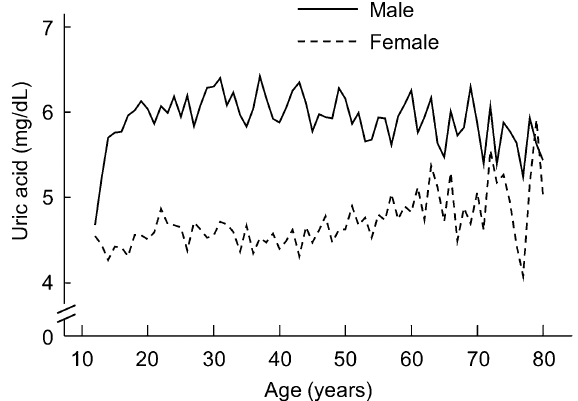
Figure 1. Serum levels of uric acid in males and females. This cohort included 5079 males and 4393 females, which represented a weighted sample size of 101,696,911 and 82,645,299, respectively. Data represent the weighted mean values over each year of age from 12 to 80 years.